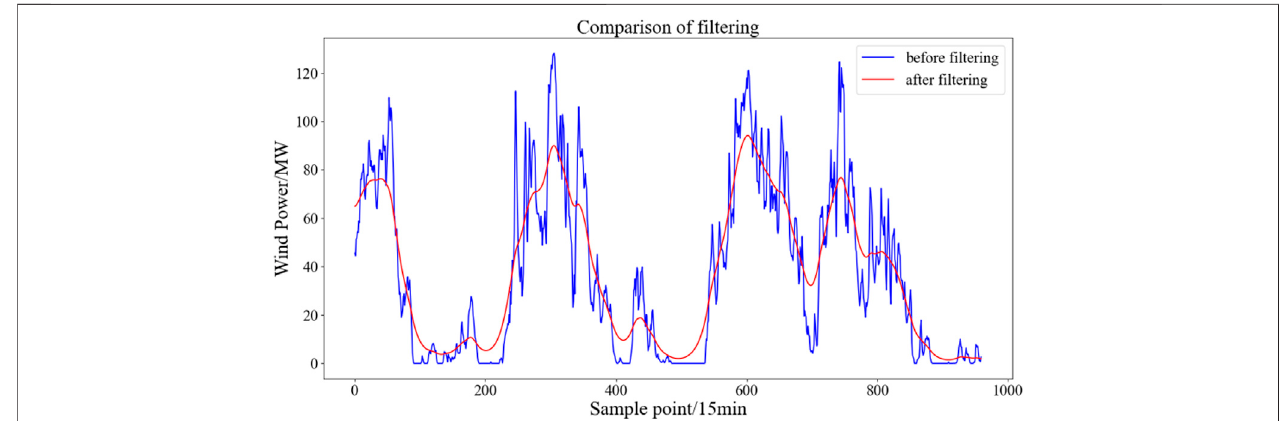
FIGURE 2 | Comparison before and after fi ltering of wind power